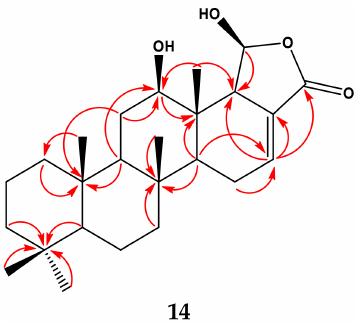
Figure 3. Selected HMBC correlations observed for Compound 14